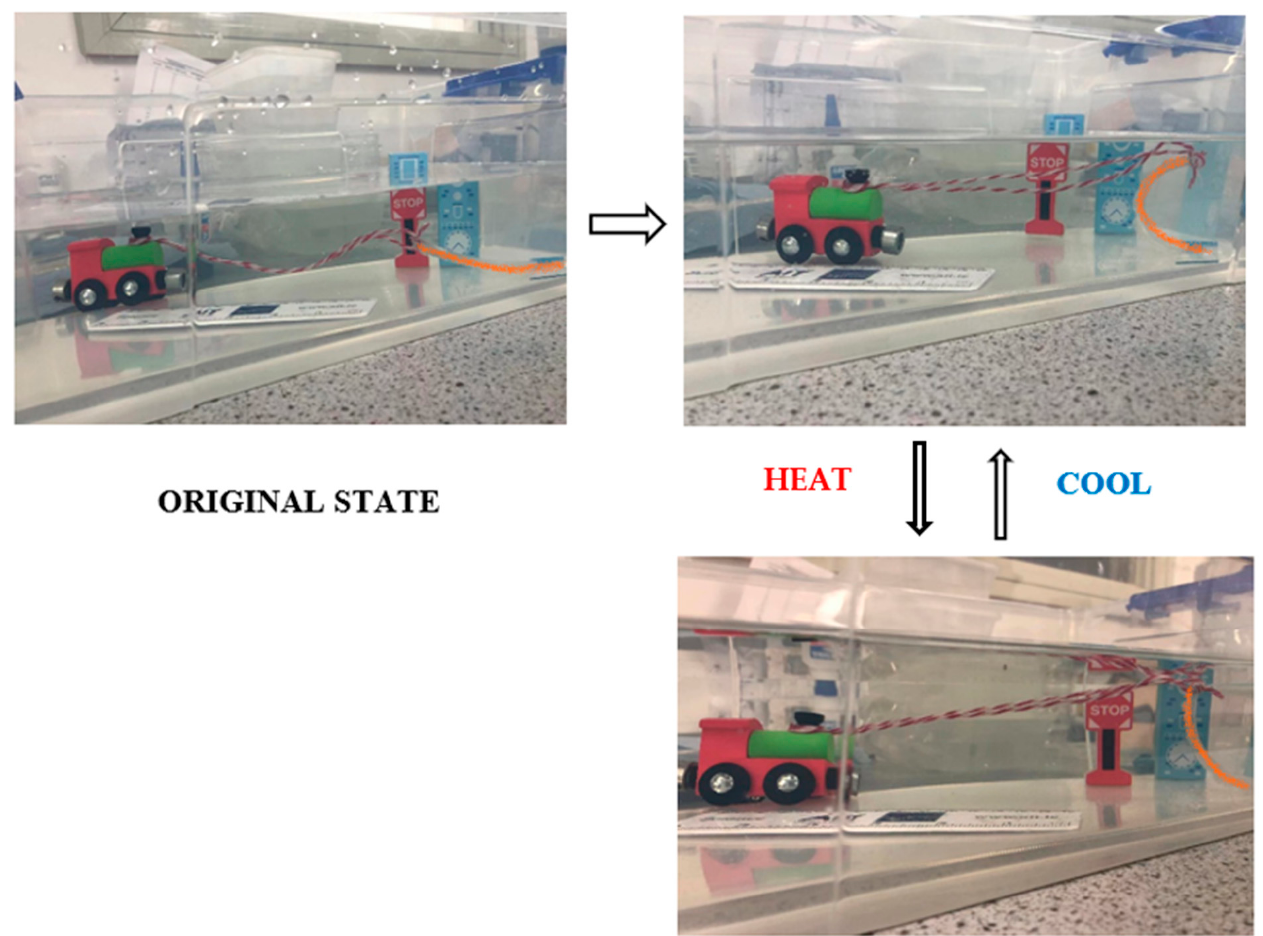
Figure 12. The toy train automatic puller achieved by using ‘b’ type bilayer strips.